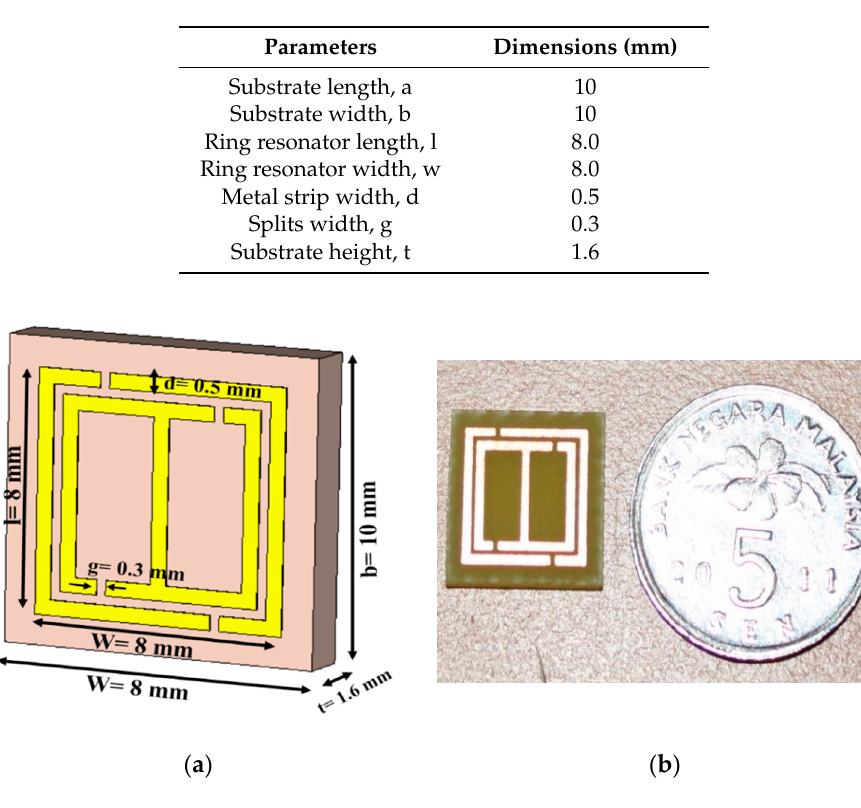
Figure 3. Fabricated 150 × 200-mm 2 (15 × 20 unit cells) array prototype of the proposed meta-atom structure.